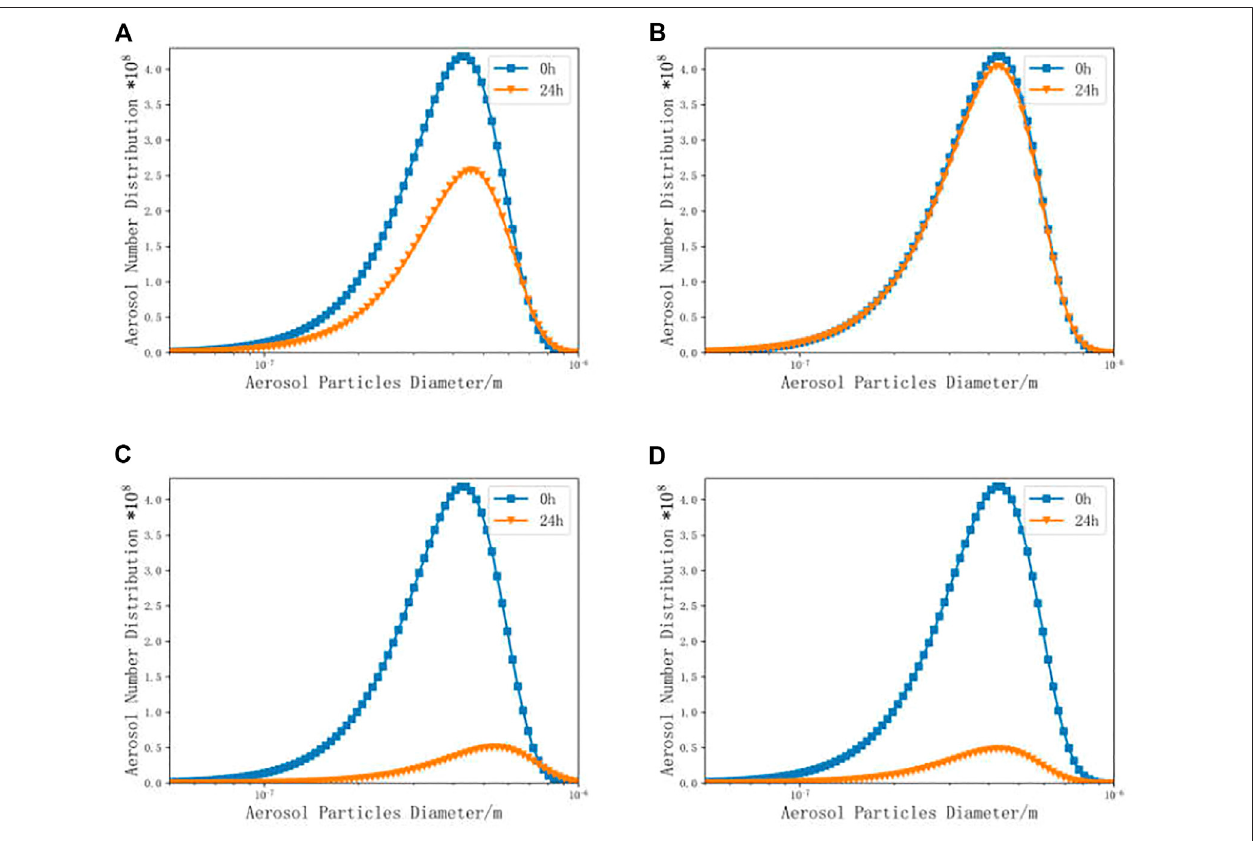
FIGURE 4 | Distribution of radioactive aerosol particles. [ (A) , constant coagulation kernel; (B) , linear coagulation kernel; (C) , constant coagulation kernel and the constant deposition rate of particles; (D) , linear coagulation kernel and the constant deposition rate of particles].